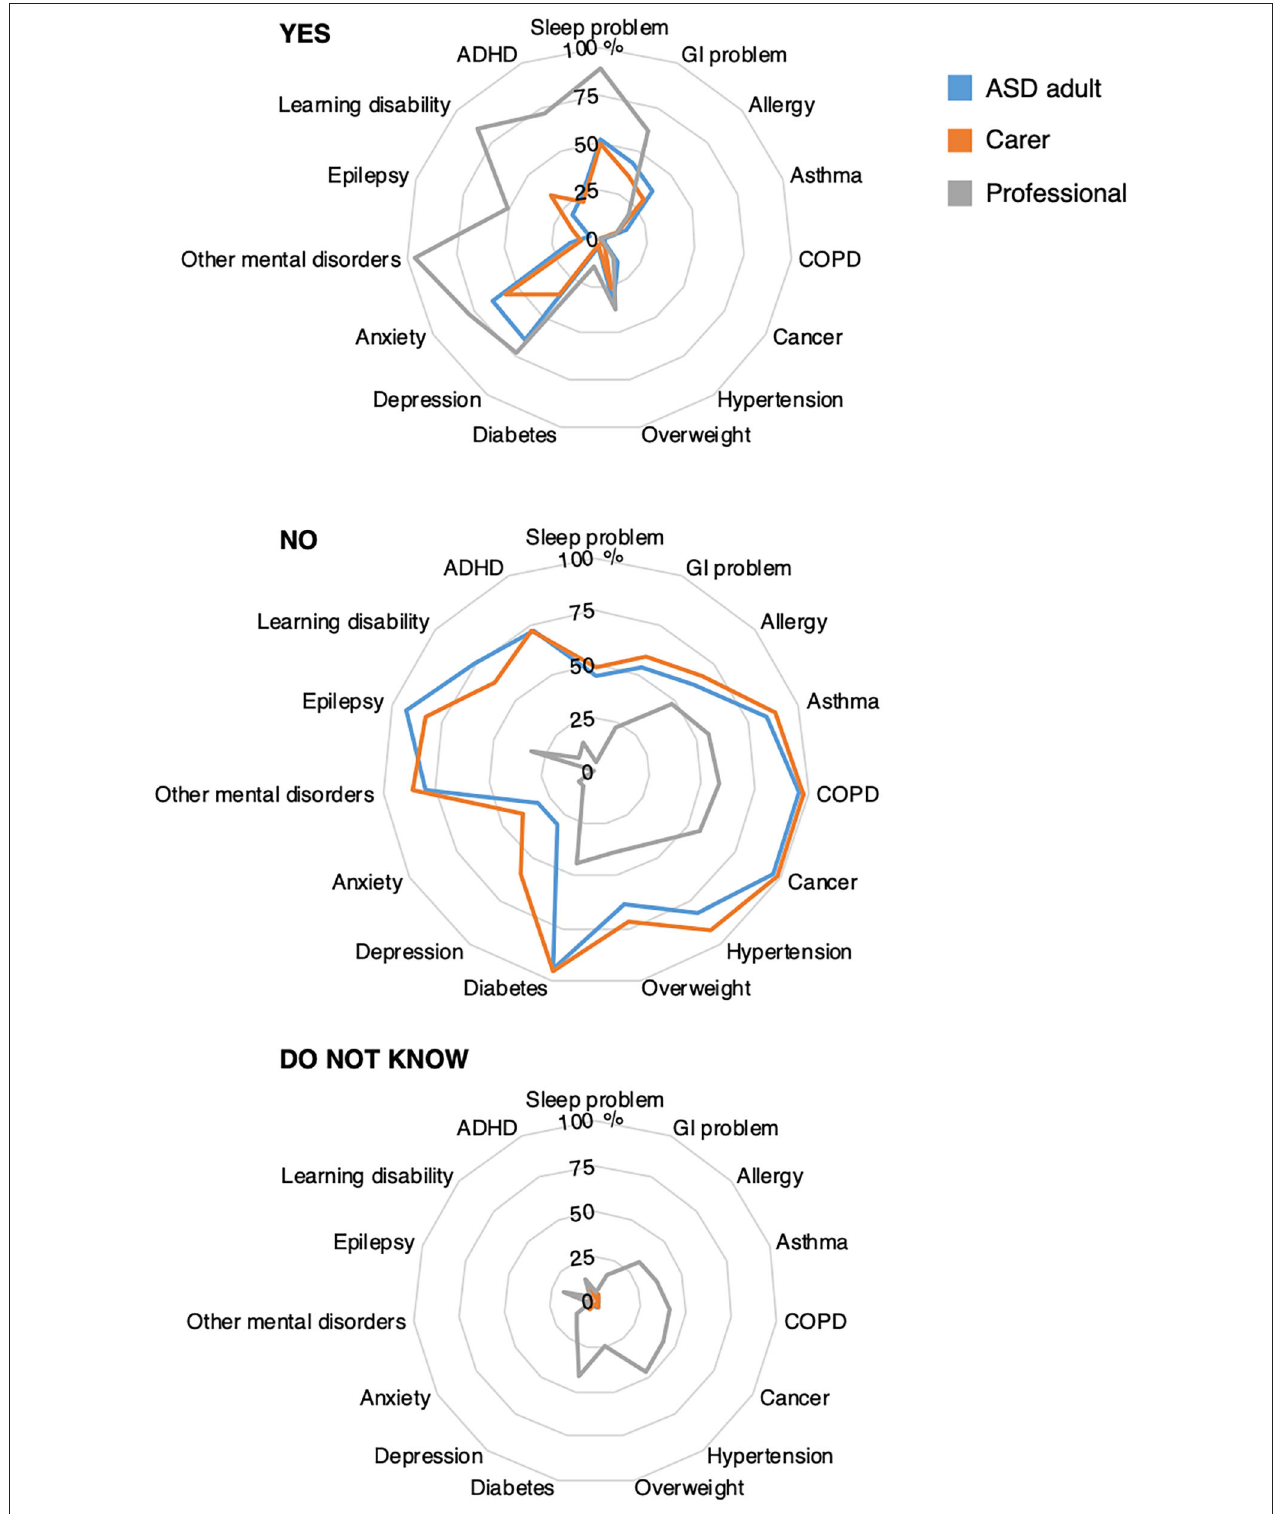
FIGURE 1 | Health profile in autistic adult. GI, gastrointestinal; COPD, chronic obstructive pulmonary disease; ADHD, attention-deficit hyperactivity disorder. Radar chart plots of the answers “YES,” “NO,” and “Do not know” at the following questions: “Since you became an adult … have you been diagnosed by a doctor with:” (autistic adults, blue line); “In the last 2 years, has the autistic adult been diagnosed or treated by a doctor for:” (carers, orange line) and “… do you believe that the following conditions are more frequent in autistic adults, compared with adults not on the autism spectrum?” (Professionals, gray line). Values expressed as percentages. N autistic adults 521 to 522; N carers 437 to 440; N professionals: 113. Infection is not displayed in the figure since it is not a chronic condition.